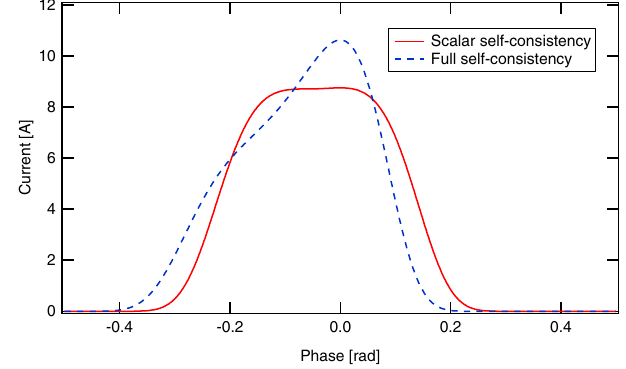
4 . 2 M Ω and s ¼